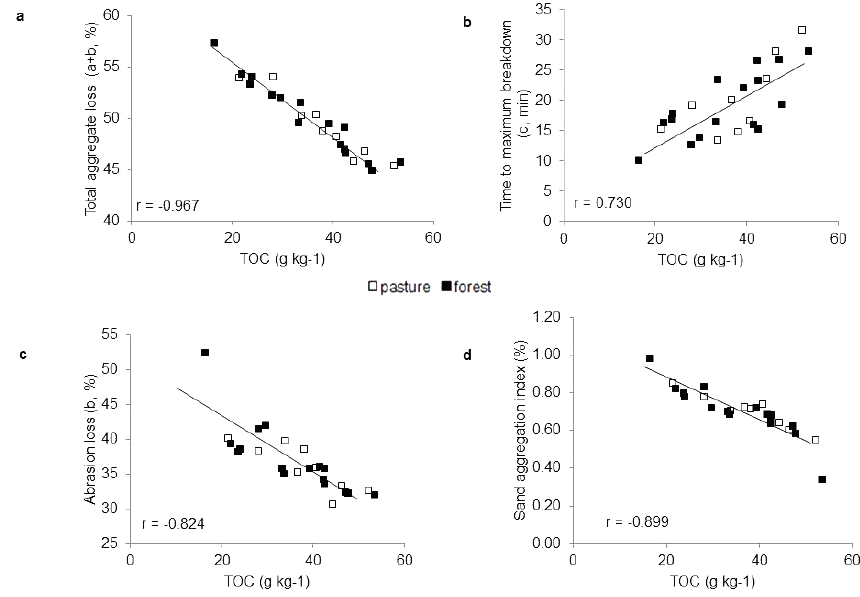
Figure 2. Correlations between organic carbon content (TOC) and aggregation stability parameters: (a) total loss of aggregates a + b ; (b) time to maximum breakdown, c ; (c) abrasion loss, b ; (d) sand aggregation index. Black squares correspond to forest, open squares to pasture. All correlations had p< 0 .